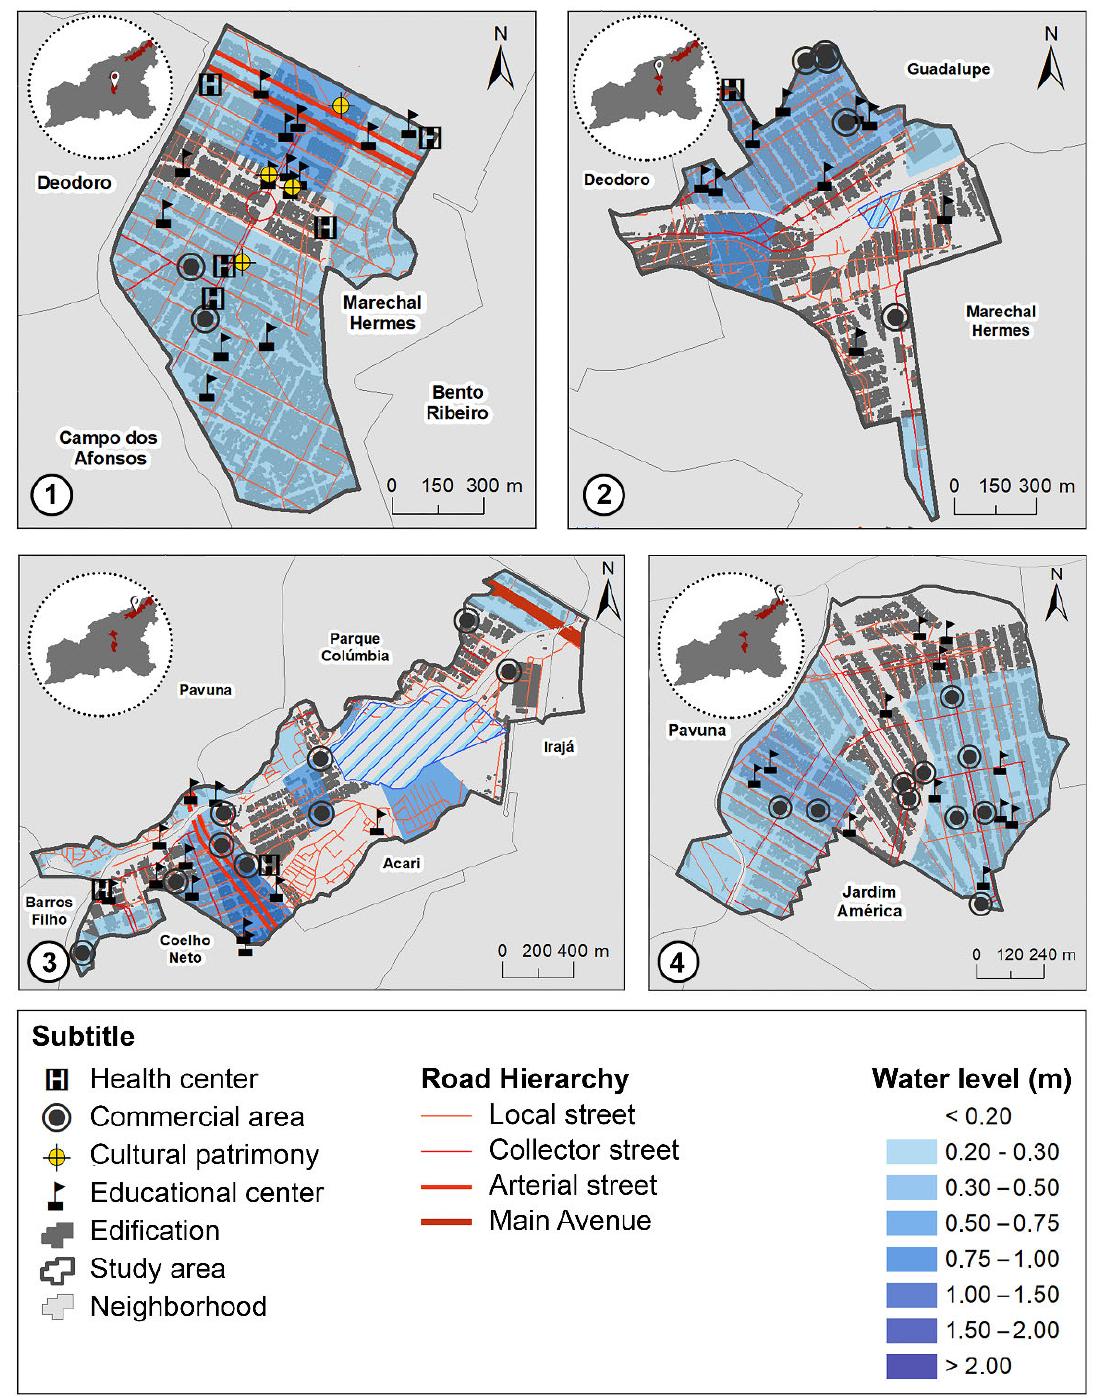
Figure 11. Summary maps of the analysis areas—Design Scenario.